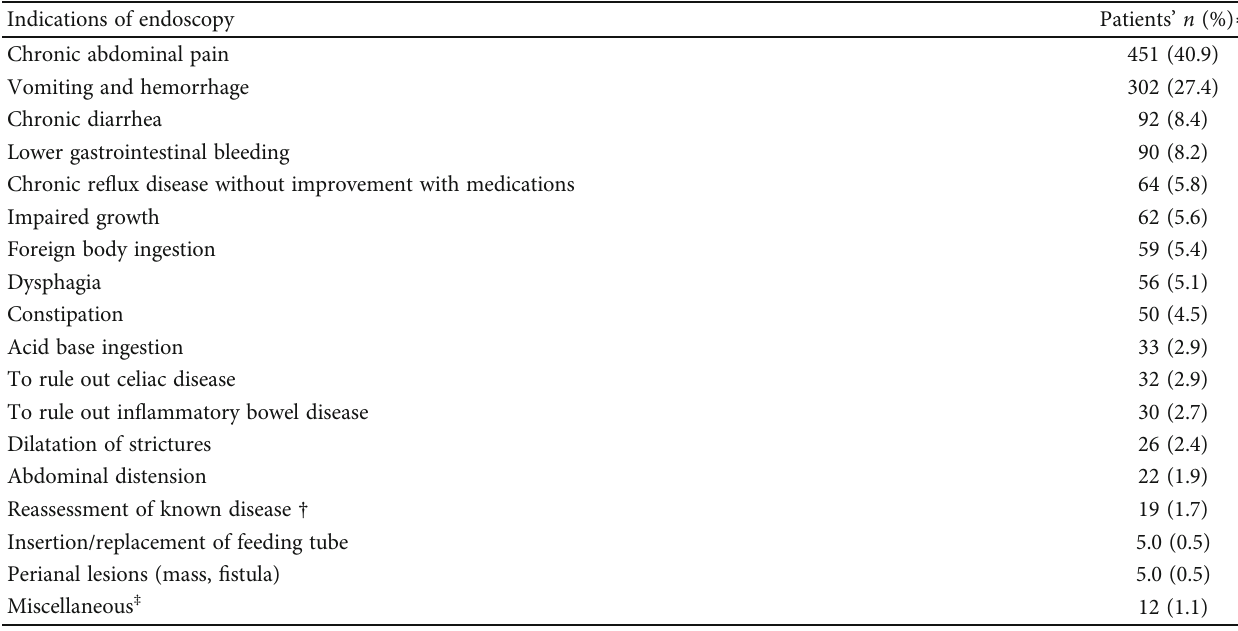
Table 2: Indications of gastrointestinal endoscopic procedures in children ( n = 1,101 ).